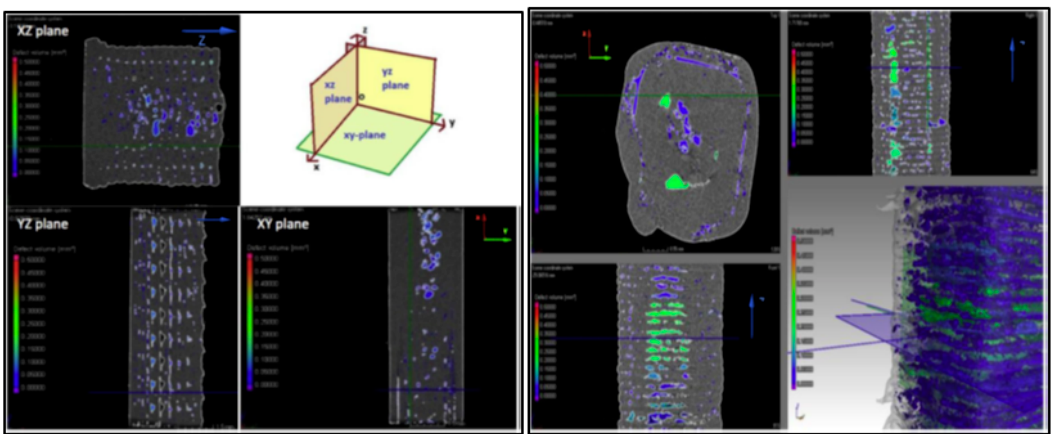
Figure 6. Computed Tomography scans of gauge length of PEEK-XY-100 (left) and PEEK-Z-100 (right) samples before tensile test [85].